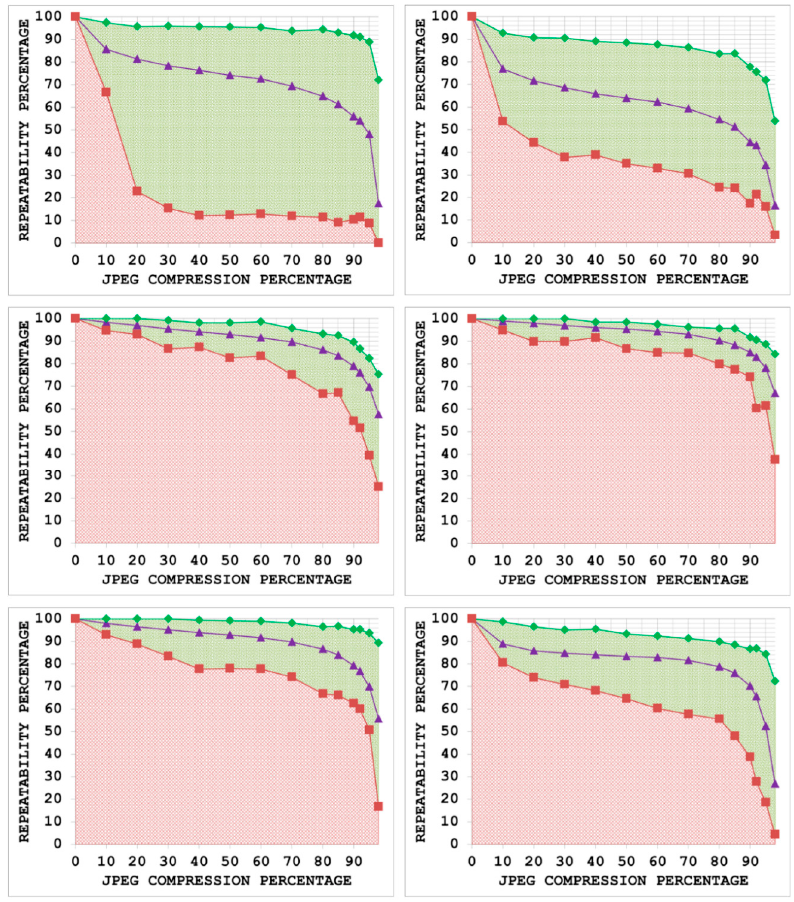
Figure 3. JPEG compression results utilizing the proposed framework and the image database for Maximally Stable Extremal Regions (MSER) ( top left ), Intensity-based Regions (IBR) ( top right ), Harris-Laplace ( center left ), Hessian-Laplace ( center right ), SURF ( bottom left ) and SIFT ( bottom right ) detectors.